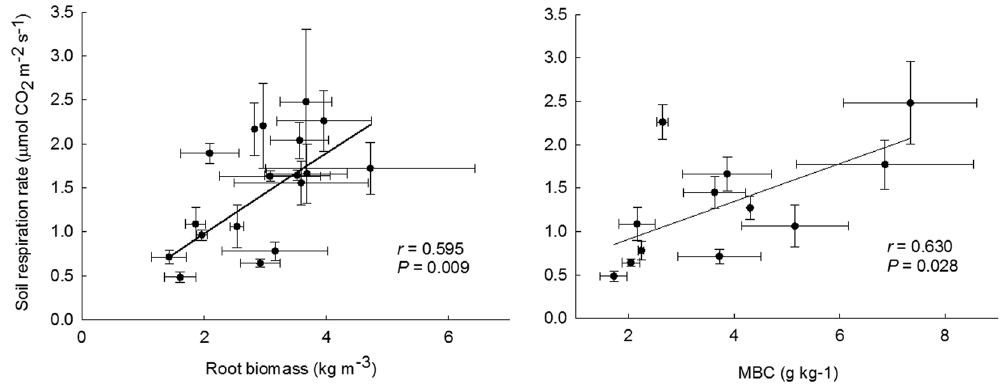
Figure 6. Relationship between soil respiration rate and root biomass or soil MBC